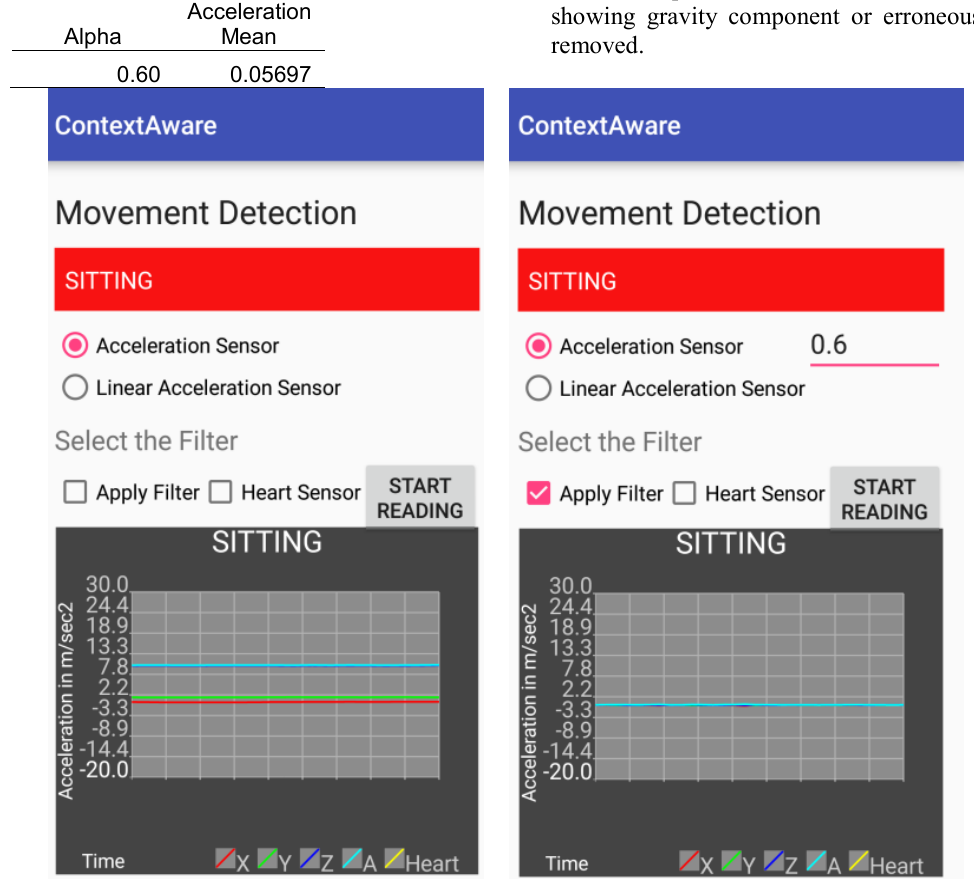
Figure 4 . Accelerometer Data in Sitting Position (left without ILPF, right with